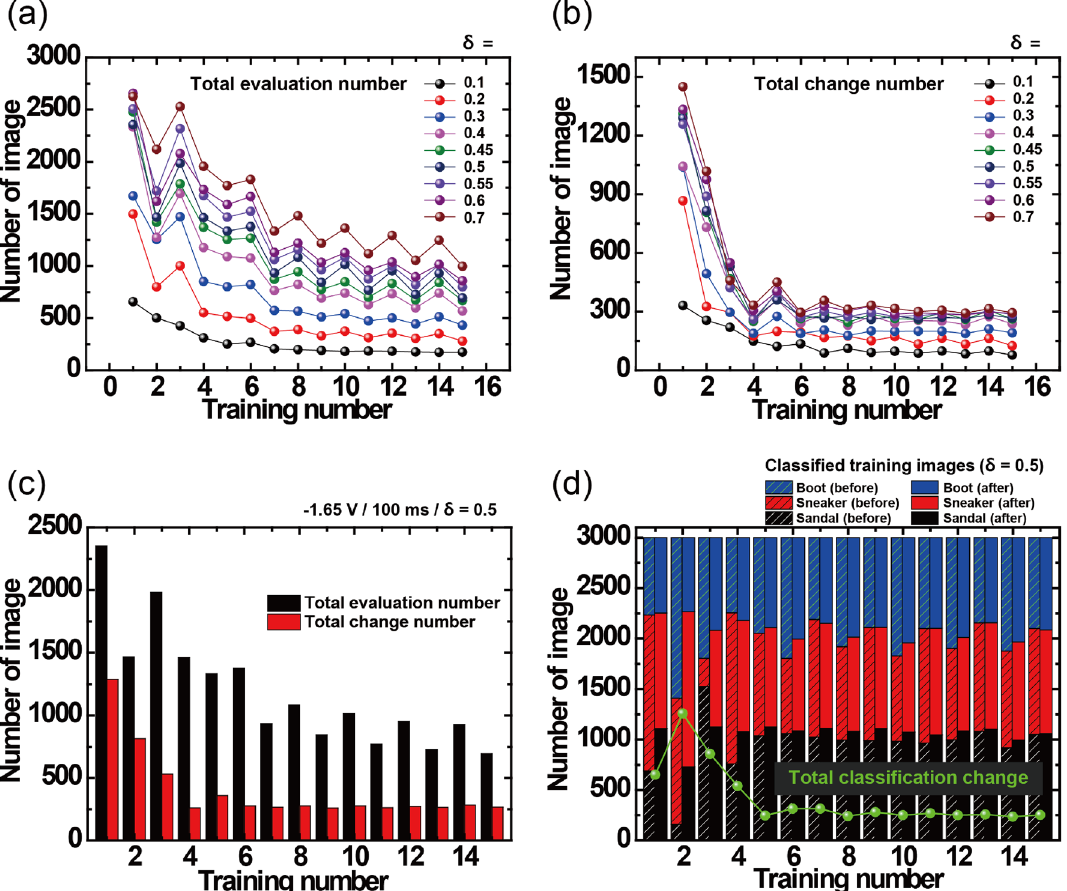
Figure 3. Number of ( a ) total evaluations and ( b ) changes for test images during 15 training numbers with δ-value variation from 0.1 to 0.7. ( c ) Total number of filter-evaluated test images (black bar) and classification changes (red bar) during 15 training numbers at a δ-value of 0.5. ( d ) Classified numbers of training images before (solidus bar) and after (filled bar) filter evaluation during 15 training numbers at a δ-value of 0.5, where the green line represents the number of total classification changes at each